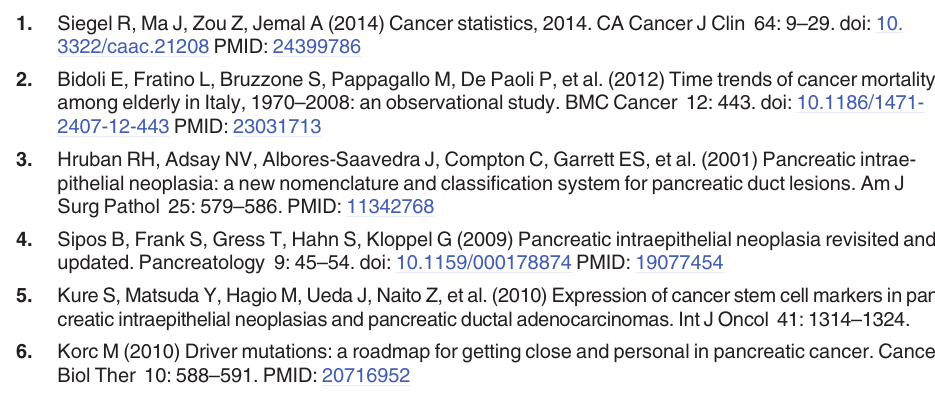
surgically resected (b, n = 36) and autopsy (c, n = 150) cases of pancreatic cancer. PanIN-1 be- came more common with increasing age, whereas PanIN-3 was not found in cases without pancreatic cancer. S2 Fig. Distributions of telomere intensity expressed as TCR in TIG-1 cells, the pancreatic duct, and ductal lesions. TCR tended to be lower in PanIN and cancer lesions than in the nor- mal duct epithelium (N-small and N-large) in a case of pancreatic cancer (a) and in a case with- out pancreatic cancer (b). S3 Fig. Comparison of NTCR in various types of tissue between pancreatic cancer cases and controls. There were no statistically significant differences in NTCR between cancer cases (gray bar) and controls (white bar). ND, no difference. S4 Fig. ROC curve analysis of NTCR for detection of pancreatic cancer. NTCR for surgically resected cases was used in ROC analysis for distinction between pancreatic cancer (including cancer and PanIN-3) and non-cancerous duct (including normal duct and PanIN-1 and − 2). S1 Table. Characteristics and incidence of PanINs in surgically resected cases. S2 Table. Characteristics and incidence of PanINs in autopsy cases. S3 Table. Telomere length and clinicopathological characteristics of surgically resected pancreatic cancer